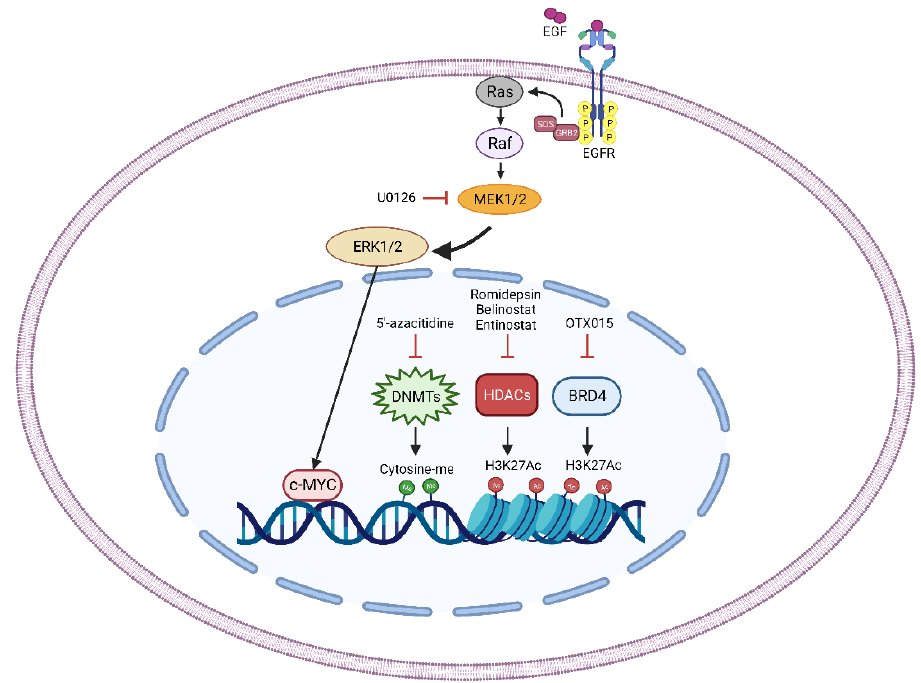
Figure 2. Schematic representation of the principal radiosensitizer targets (MEK/ERK pathway, DNMTs, HDACs, and BRD4) discovered in RMS. Treatment with U0126, a MEK inhibitor, decreases the activation of MEK/ERK pathway thus affecting the pro-tumorigenic abilities of the transcription factor c-MYC. The treatment with 5′ -azacitidine reduces DNA methylation by specifically inhibiting DNA methyltransferases (DNMTs). Romidepsin, Belinostat, and Entinostat pharmacologically target Histone Deacetylases (HDACs) increasing the acetylation of Lysine 27 of the Histone 3 (H3K27ac). Bromodomain-containing protein 4 (BRD4) is directly inhibited by OTX015 treatment thus affecting its ability to read and bind the H3K27ac residues. Pharmacologic perturbation of the identified molecules increases RT-induced cytotoxic effects.